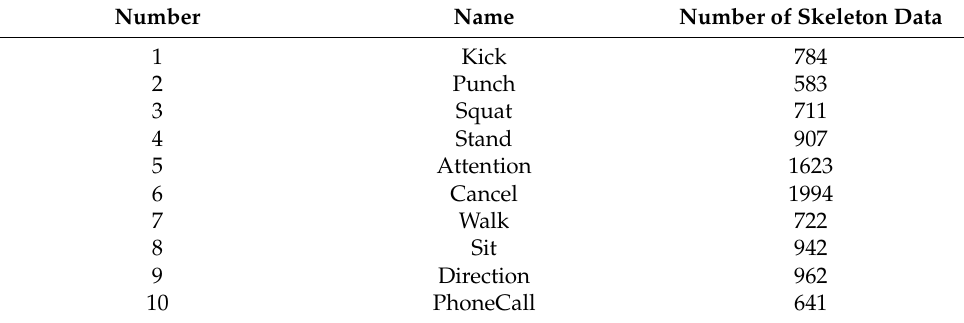
Table 4. UAV body rescue gestures dataset details.